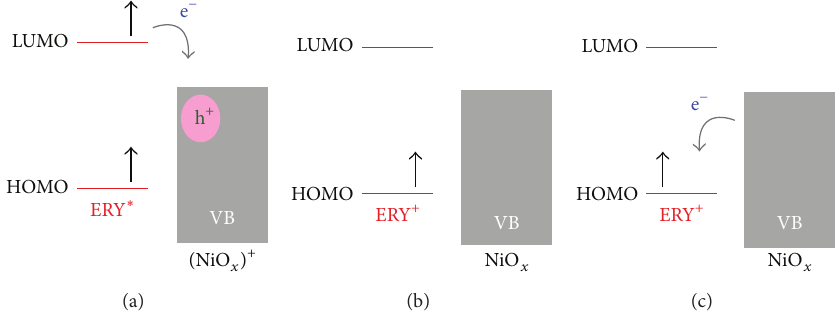
Figure25:HypothesisofmechanismofelectrochemicallyinducedchargeinjectionfromphotoexcitedERYsensitizertomesoporousRDS/CS within the potential range of NiO oxidation (2.8–3.7 V versus Li + /Li). (a) Electron is injected in the valence band (VB) of oxidized NiO x x from excited ERY colorant; (b) upon neutralization of the hole that has been electrochemically injected in NiO RDS/CS NiO x ERY would retain a positive charge with formation of the combination ERY + -NiO to the HOMO of ERY + . Further electrochemical oxidation of NiO an electron from the VB of neutral NiO x sensitizer is in the oxidized state (not shown).